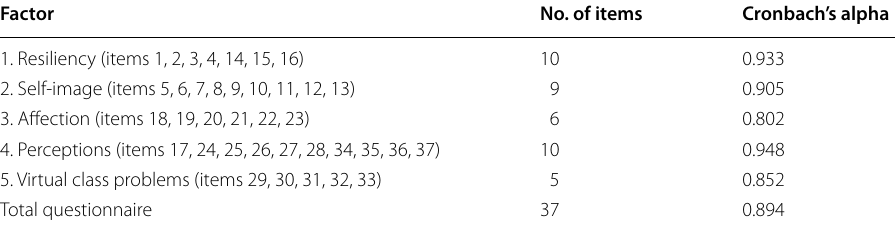
Table 5 Five factors of APPRSQ with related reliability indices Factor No. of items Cronbach’s